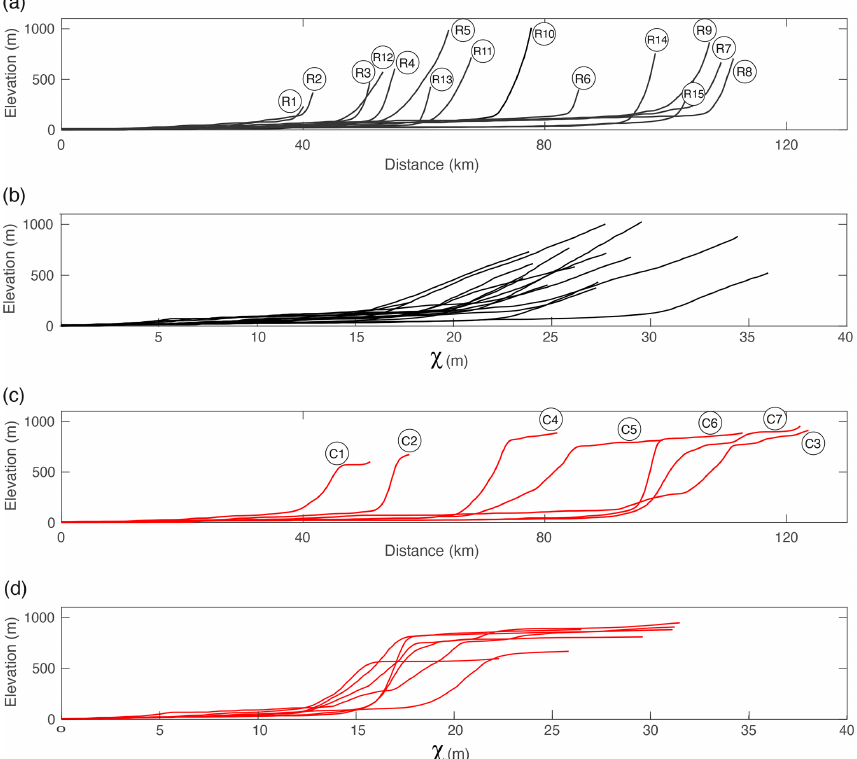
Figure 3. River profiles and corresponding transformed χ profiles in the southern Western Ghats. Locations of these rivers are indicated in Fig. 2a. Rivers are extracted from 90m SRTM data and use a threshold drainage area of 1km 2 . The χ value of rivers is calculated using a base level of sea level and concavity of 0.42, and precipitation is not included. (a, b) Profiles of escarpment rivers that initiate from the escarpment. (c, d) Profiles of escarpment rivers that initiate from the plateau interior and drain through the